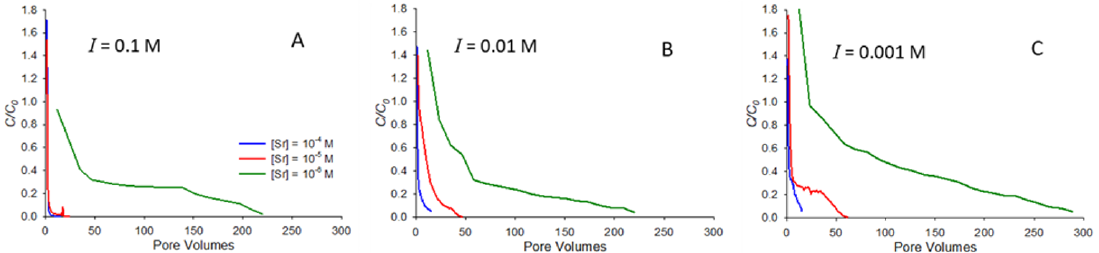
Figure 4. Remobilization elution curves showing the release of strontium at pH 9 following resaturation after the evaporation of porewater. Experiments correspond to ionic strengths of 0.1 ( A ), 0.01 ( B ), and 0.001 M ( C ) NaNO 3 . Curves are shown for elution after saturated breakthrough at initial strontium concentrations ( C 0 ) of 10 −4 M, 10 −5 M, and 10 −6 M.